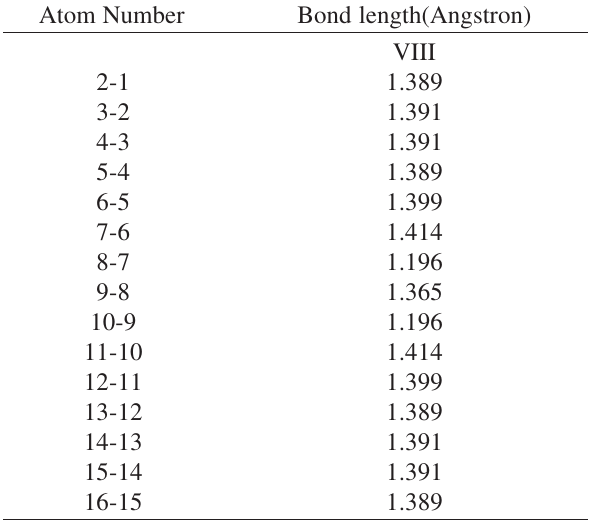
Table 5. Bond Length (Angstrons) of the alkyne VIII described by Table